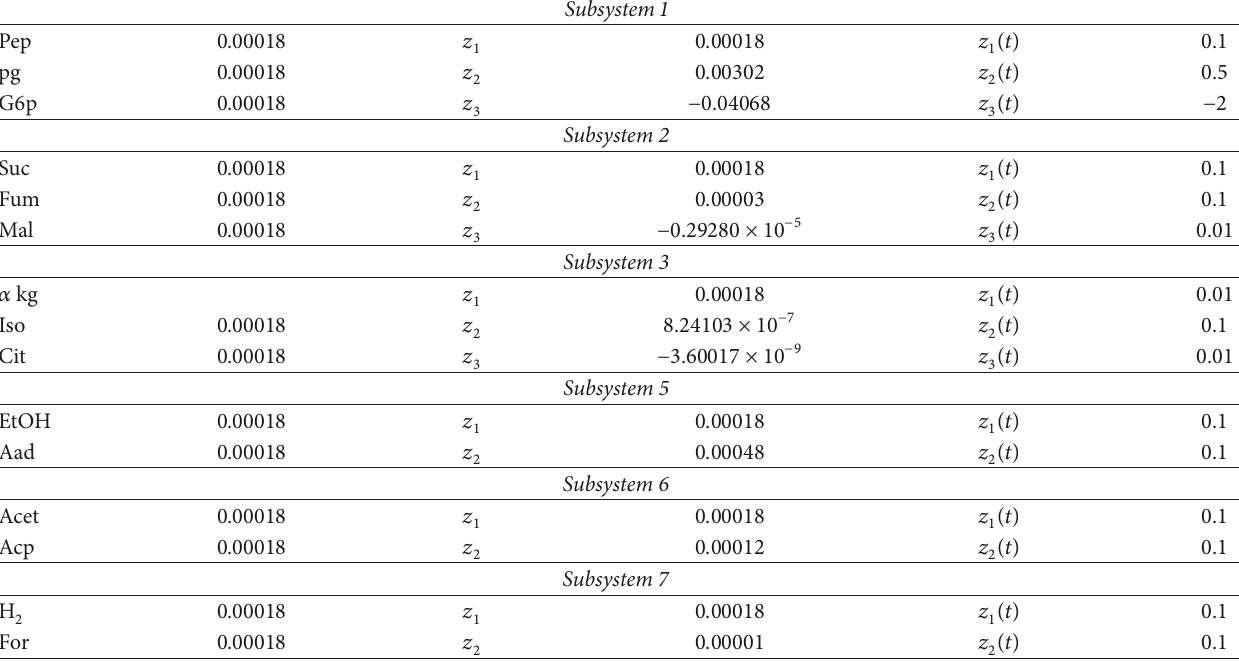
Table 4: Initial conditions on 𝑧 space and original